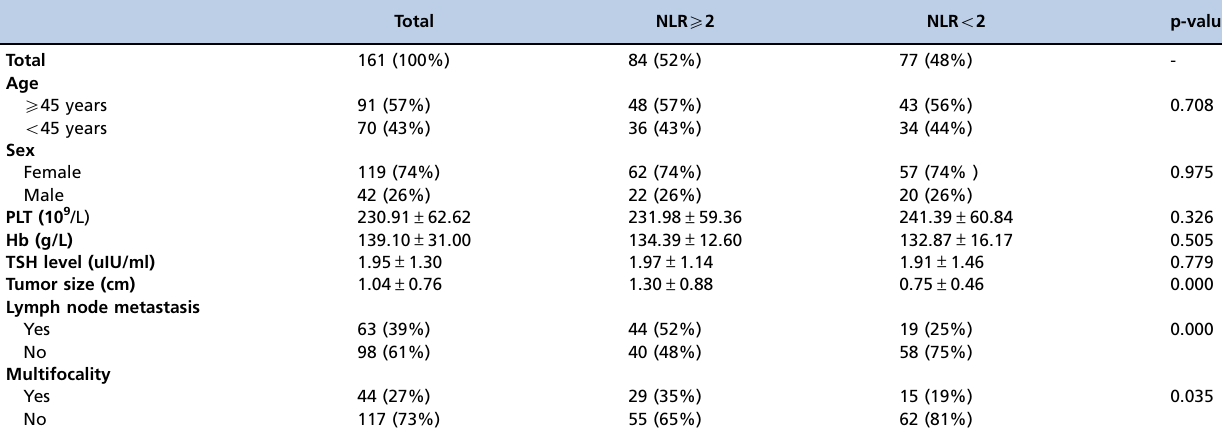
Table 1 - Patient characteristics according to the preoperative neutrophil-to-lymphocyte ratio.